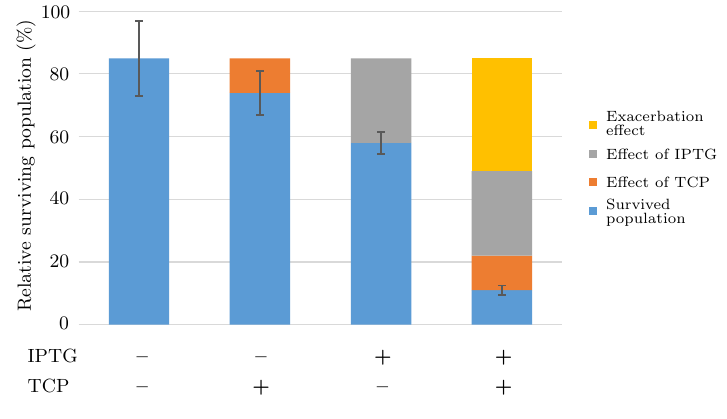
Figure 9. Evidence of exacerbation effect of IPTG on toxicity caused by TCP. Combined effect of metabolic burden caused by 0.2 mM IPTG and toxicity caused by TCP on E. coli BL21(DE3) cells carrying empty plasmids pCDF and pETDuet is displayed as the percentage of survived cells (blue bars) after induction in medium with or without 2 mM TCP. Pre-induced (IPTG + ) or non-induced (IPTG ) cells were incubated in buffer with TCP (TCP + ) or without (TCP − effects of TCP (orange), IPTG (gray), and the exacerbation of TCP toxicity in cells pre-induced with IPTG (yellow) are indicated. Error bars represent standard deviations calculated from at least five independent experiments. Note that experimental data come from